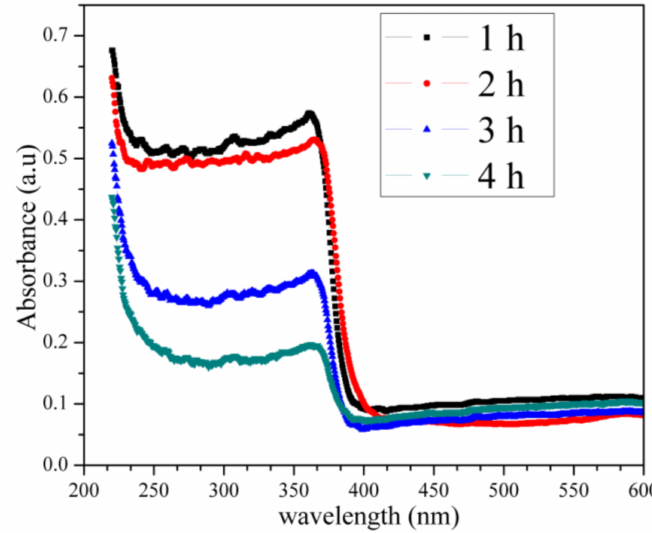
Figure 10. The optical absorbance spectra of the willemite NPs fabricated 900 ◦ C for several holding